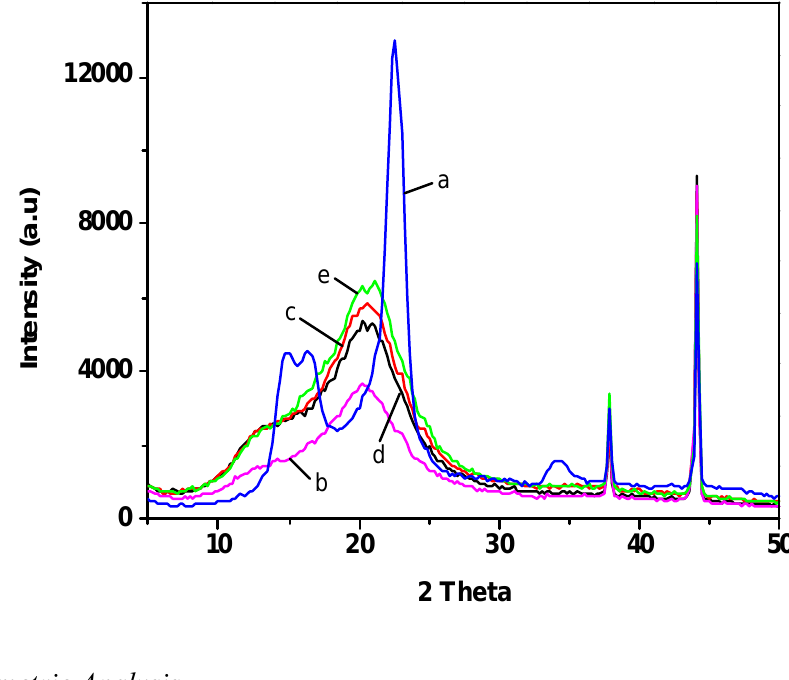
Figure 4. X-ray diffraction (XRD) images of samples: ( a ) cotton linter; ( b ) control sample; ( c ) cellulose film plasticized with sorbitol; ( d ) cellulose film plasticized with glycerol; ( e ) cellulose film plasticized with